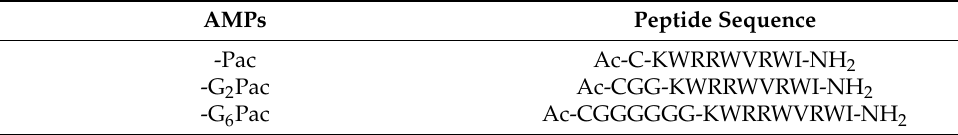
Table 1. The sequences of the AMPs used in this study.